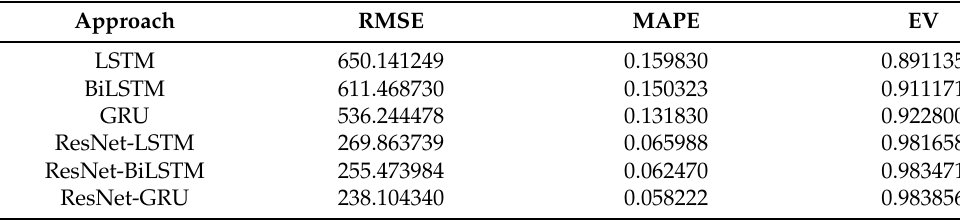
Table 5. Error Metrics.